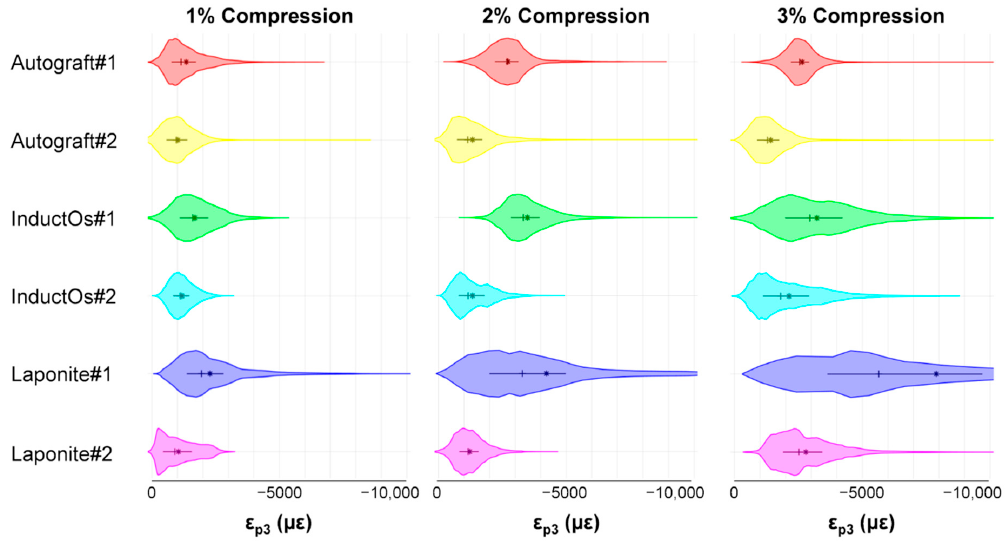
Figure 4. Violin plots showing the third principal strain distribution ( ε p3 ) in the VOI of the six specimens at each compression step smoothed by a kernel density function. Median ( + ) and mean (*) values are indicated in each plot. Horizontal lines show the inter-quartile range (IQR, between 25th and 75th percentile of the data).